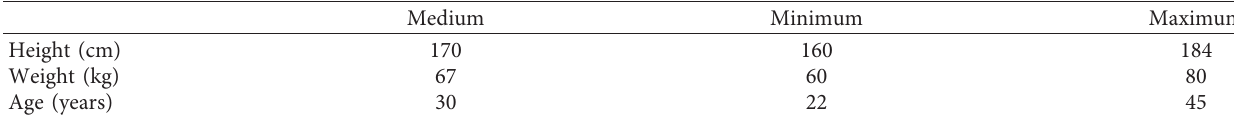
Table 1: The statistical data of subject’s personal